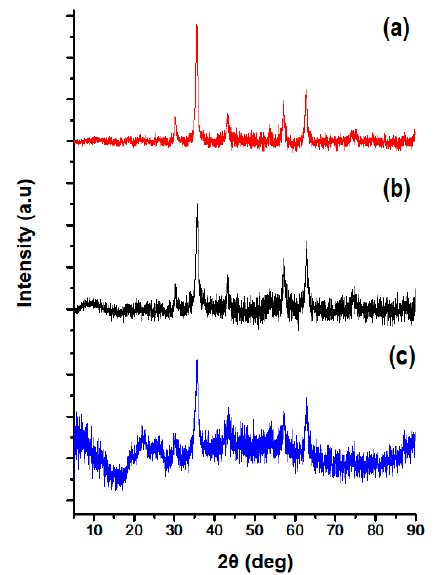
Figure 3. TGA thermograms of ( a ) pristine SPIONs and ( b ) CLA-coated SPIONs demonstrating weight loss (%) over a temperature range of 30–900 °C.